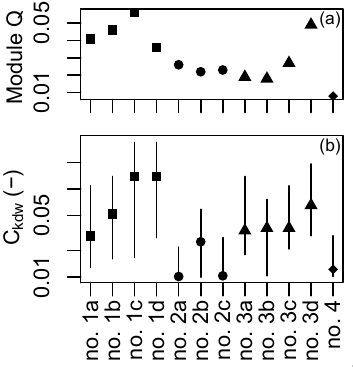
Figure 7. (a) : Mean inter-annual discharge (m 3 km − 2 s − 1 ) for the catchments. (b) : a posteriori distribution of the calibration of the subsoil horizon hydraulic conductivity in the SSF-DWF model (the C kdw parameter; Eq.